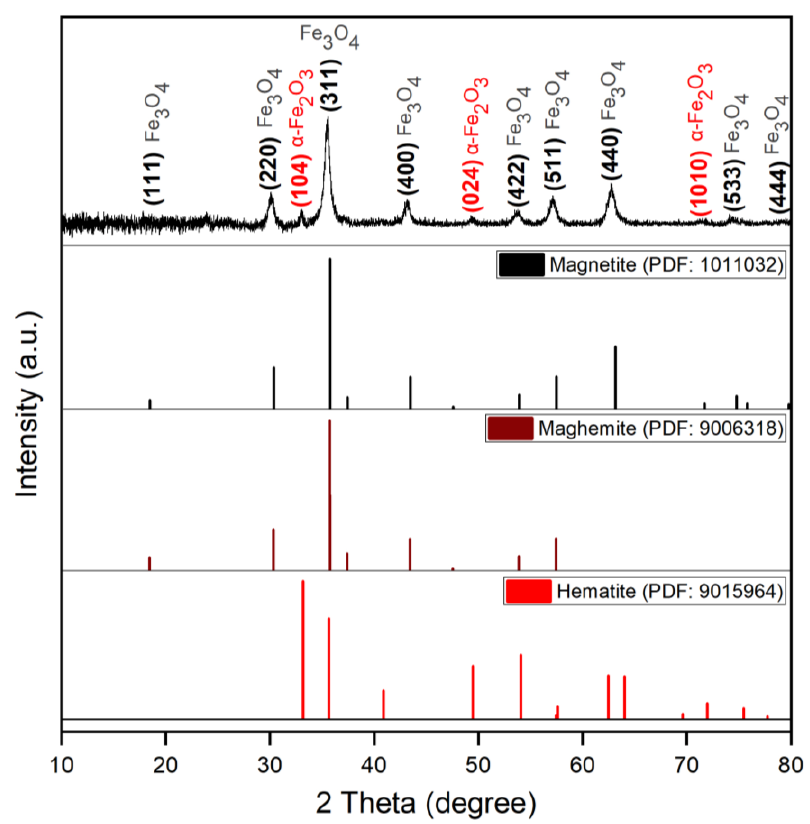
Figure 1. XRD pattern of naked MIONPs compared to the XRD patterns of magnetite (black), maghemite (brick), and hematite (red) from the International Centre for Diffraction Data Powder Diffraction File (ICDD PDF) 4+ 2019 data.